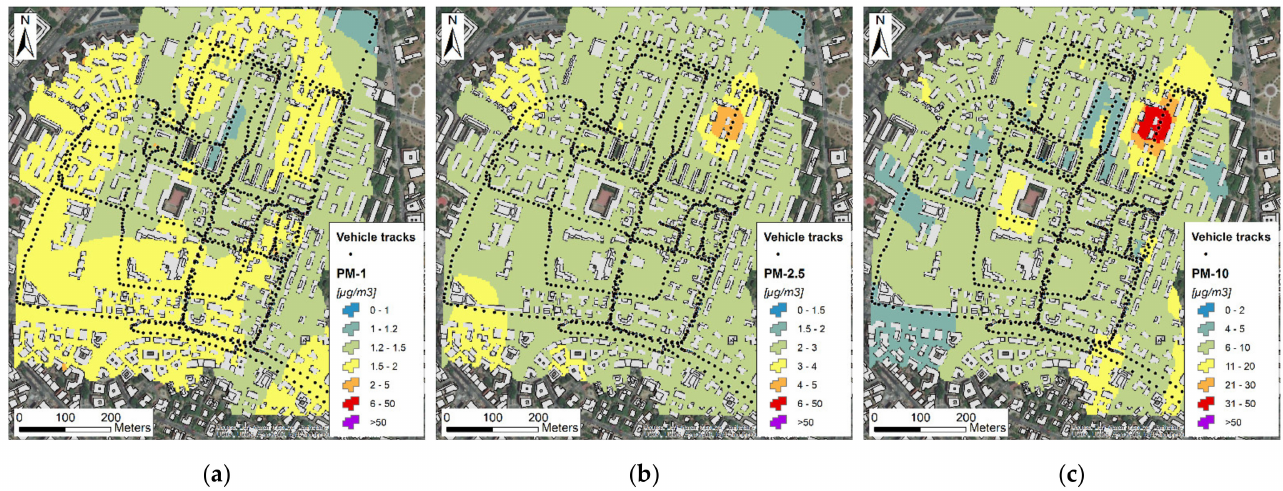
Figure 7. The results of the interpolation with barriers: ( a ) PM-1; ( b ) PM-2.5; ( c )